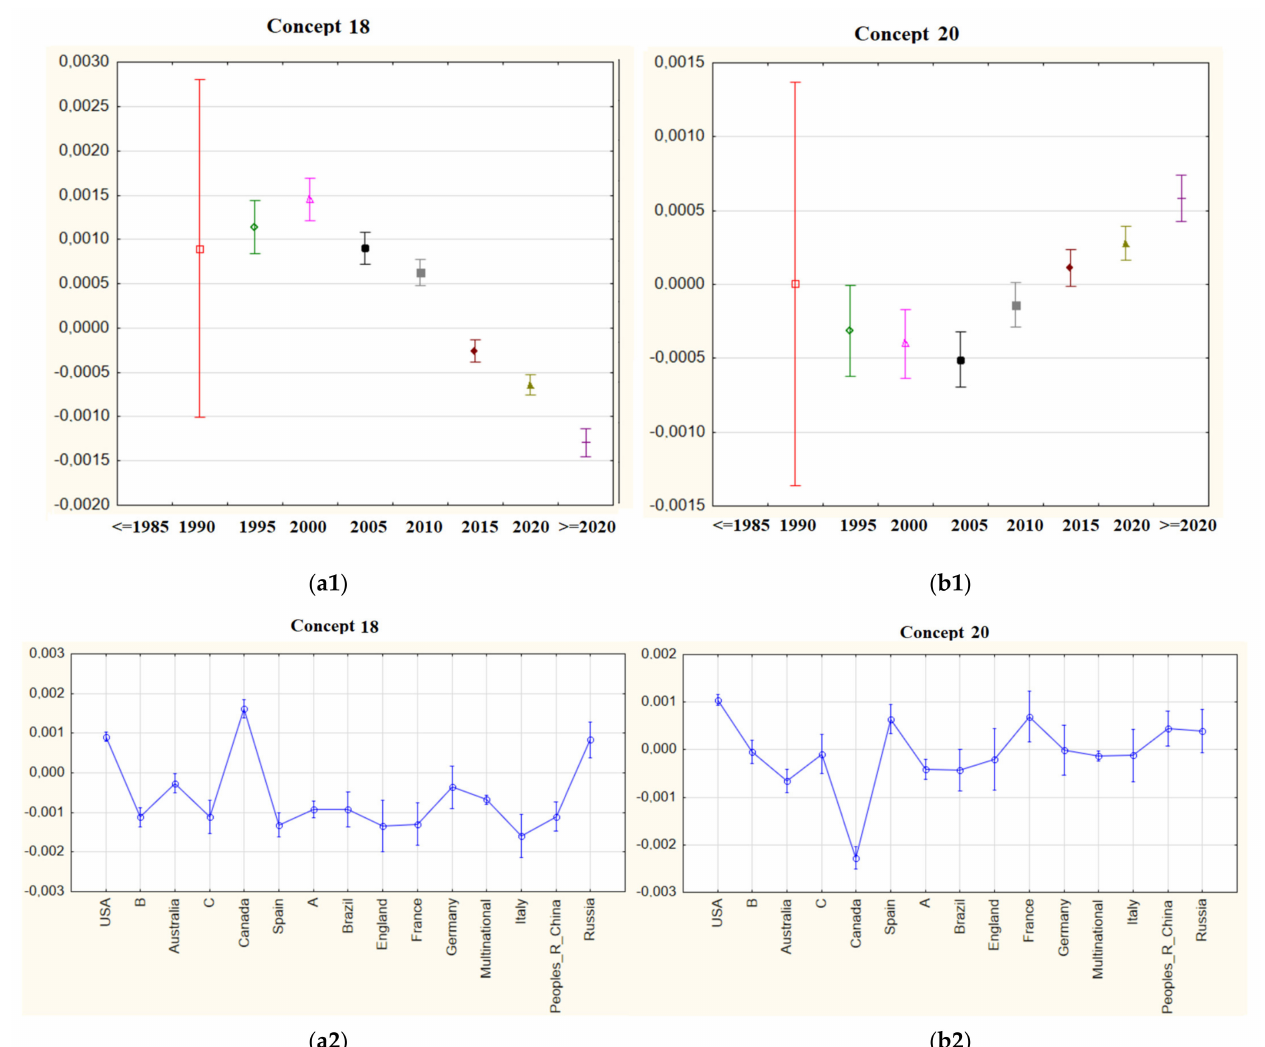
Figure 18. ( a1 ) mean importance weights of Concept 18 for five-year periods; ( b1 ) mean importance weights of Concept 20 for five-year periods; ( a2 ) mean importance weights of Concept 18 via countries; ( b2 ) mean importance weights of Concept 20 via